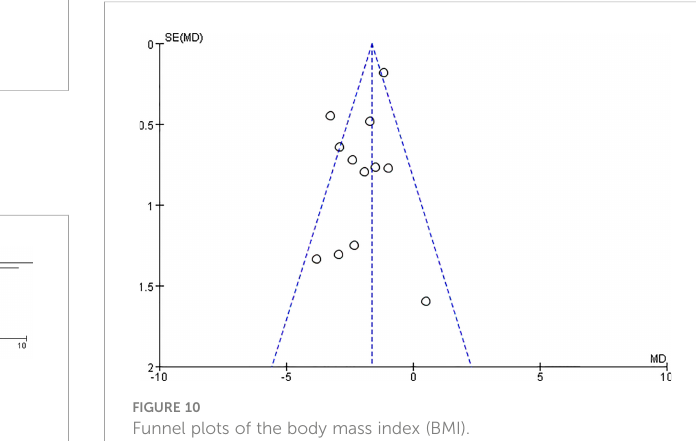
FIGURE 6 Forest plots for traditional Chinese exercise (TCE) on body fat mass (BFM).